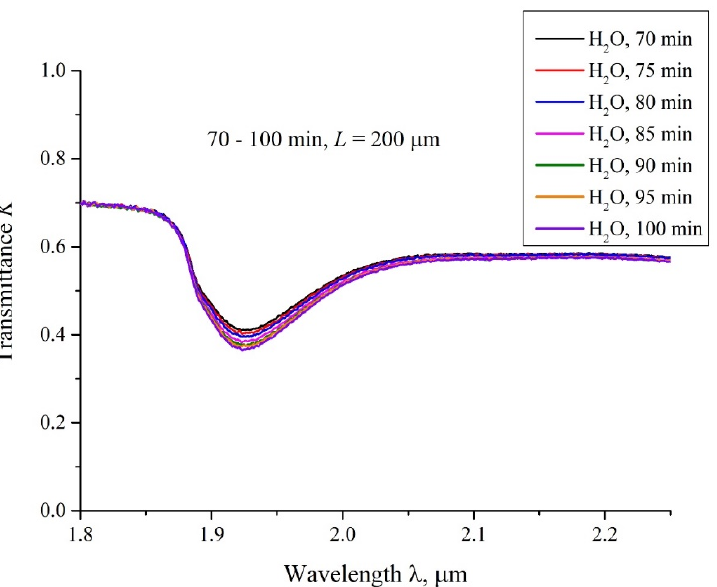
Figure 5. The transmittance spectra in the range 1.8 < λ < 2.2 µ m for the case of swelling Nafion in ordinary water; the distance between the windows L = 200 µ m, the curves are related to the swelling times t = 70, 75, 80, 85, 90, 95 and 100 min.